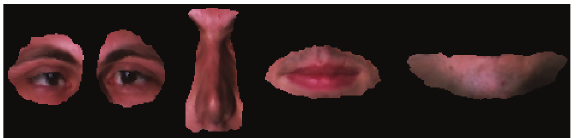
Figure 5: Four facial features decomposed from the level 2 normal